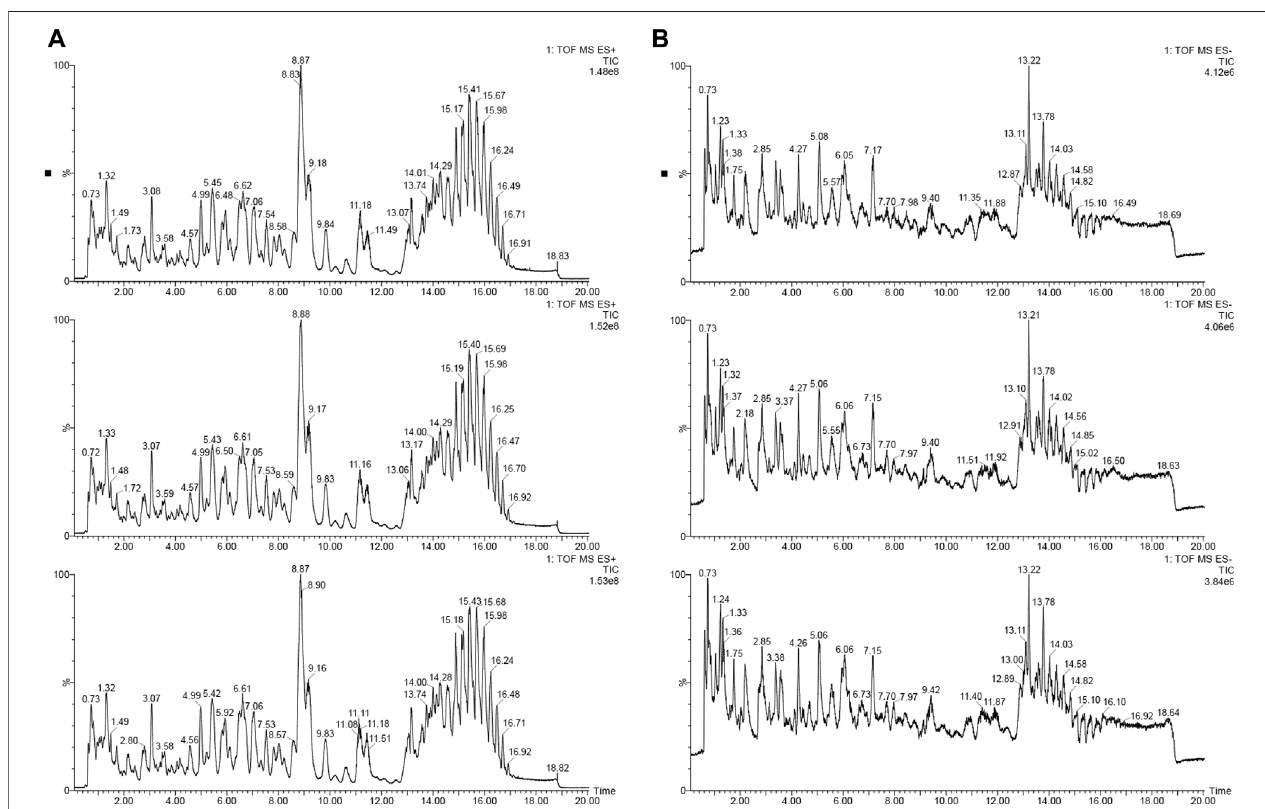
FIGURE 1 | The base peak intensity chromatogram (BPI) of positive and negative ion [ (A) : positive iron; (B) : negative ion].